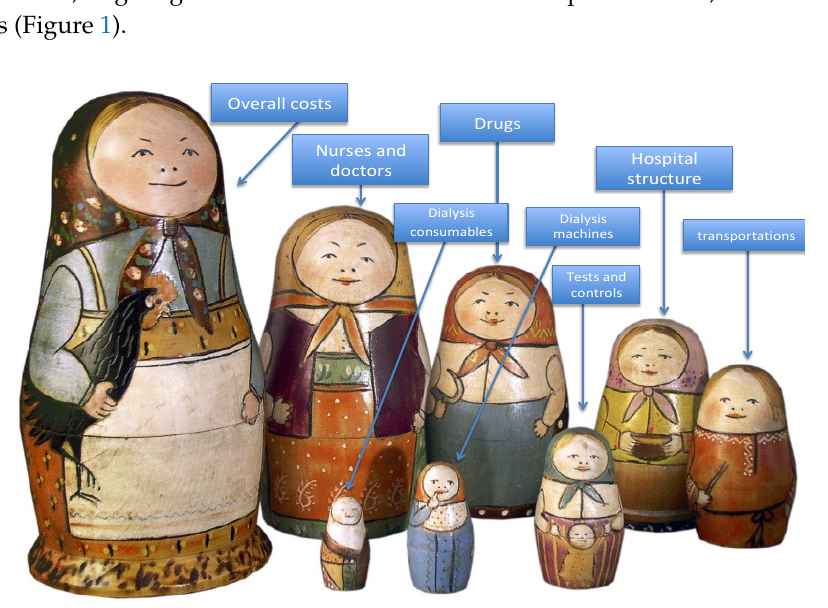
Figure 1. Dialysis costs as a matryoshka.